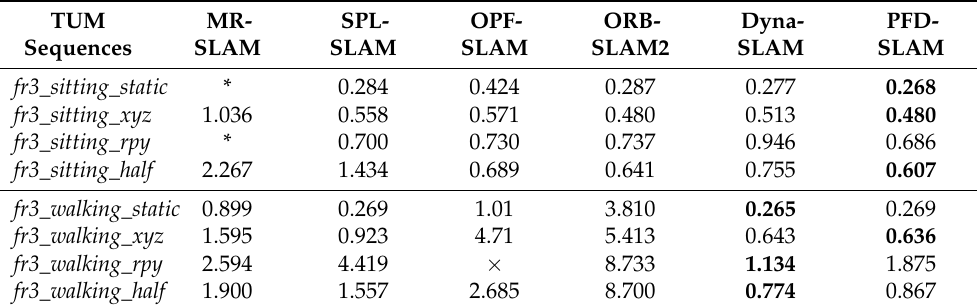
Table 4. Comparisons of RPE-RMSE (deg/s) in rotational drift on the TUM datasets.